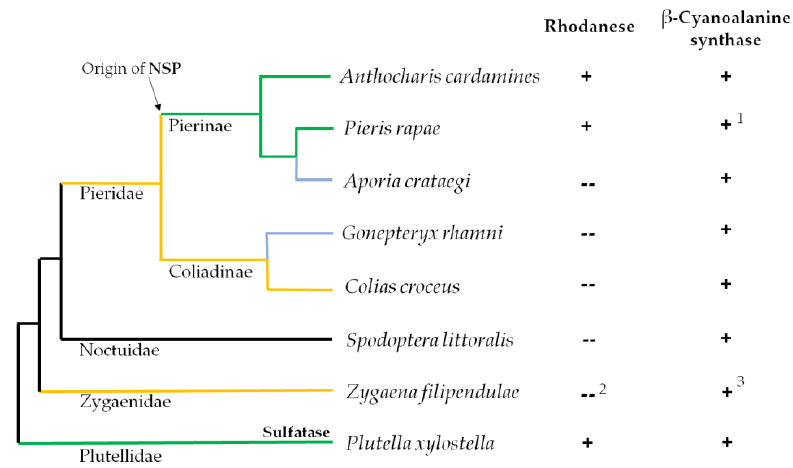
Figure 2. Presence of rhodanese and β -cyanoalanine synthase activities in lepidopteran species. Schematic representation of the phylogenetic relation between species based on [17]. Species were selected based on their feeding preferences and evolutionary history. Green lines: glucosinolate-feeding specialists; Yellow lines: species feeding on Fabaceae; Blue lines: species with secondary host shift to Rosaceae ( A. crataegi ) or Rhamnus-species ( G. rhamni ). Insect countermeasures against the glucosinolate-myrosinase system are indicated for glucosinolate-feeding specialists. Rhodanese (Rho) and β-cyanoalanine synthase (βCAS) activities were determined in extracts of different parts of the larvae (see Sections 2.4 and 2.5 for details) unless reports on activity were available in the literature. + activity detected; -- no detectable activity. 1 according to [13]; 2 according to [18,19]; 3 according to R. Davis referred to in [18].